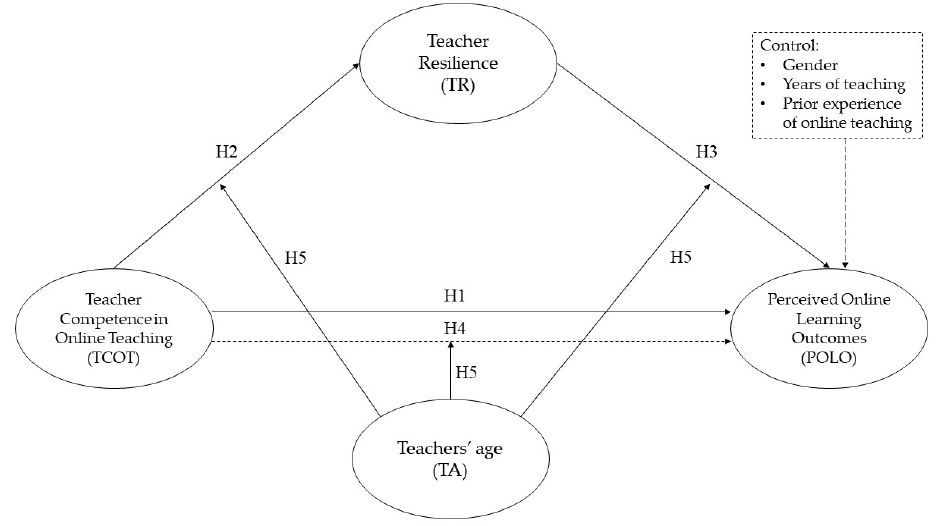
Figure 1. The moderated-mediation model. (Source: drawn up by the